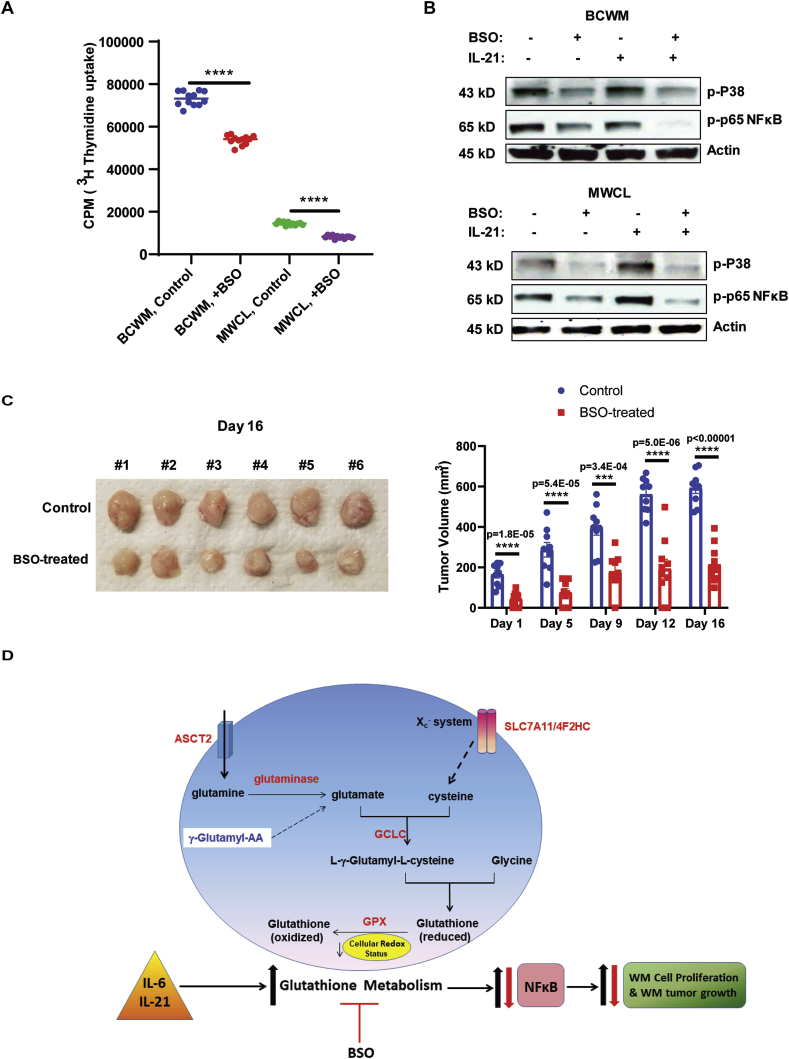
Inhibition of glutathione synthesis reduces the proliferation of WM cells both in vitro and in vivo murine xenograft tumors. A) Proliferation assay showing the effects of BSO on proliferation of BCWM.1 and MWCL-1 cell lines three days post-treatment using 3H-Thymidine incorporation assay. B) Western Blot analysis showing the phosphorylation of NFκB-p65 and MAPK-p38 in the WM cells treated with/without IL-21 (10 μg/ml) and BSO (150 μg/ml). C) Mice were implanted with 4x106 MWCL-1 cells and then treated with 20 mM BSO or left untreated. The volume of the tumors were recorded twice/week after the visible tumor appeared (day0). Tumor growth rate was graphed in both control non-treated and BSO-treated mice over 21 days. D) Schematic representation showing the summary of the data and describes how the increased glutathione metabolism promotes WM cell proliferation (blue arrow) and treatment with BSO reverses this effect (red arrow). (For interpretation of the references to colour in this figure legend, the reader is referred to the Web version of this article.)